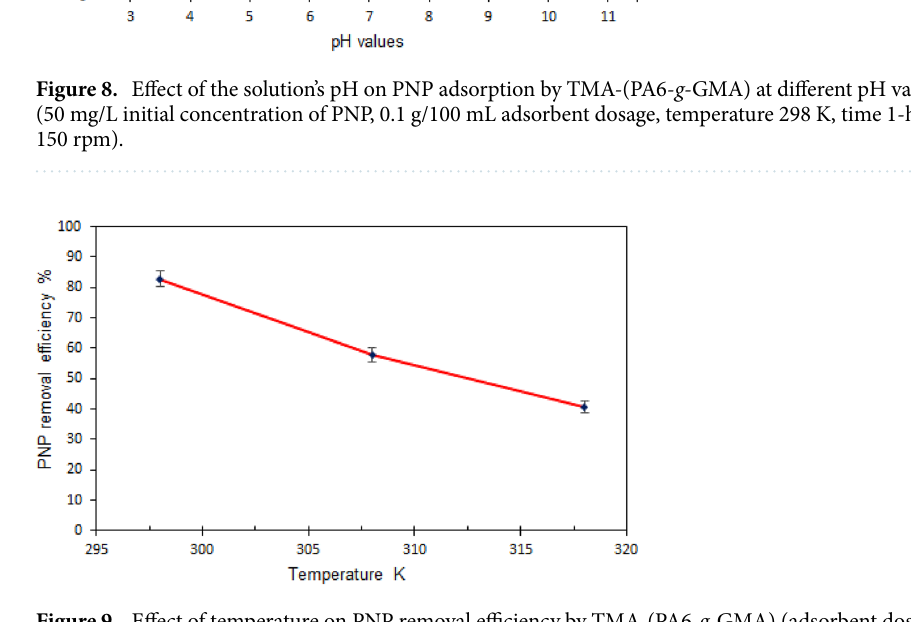
Figure 9. Effect of temperature on PNP removal efficiency by TMA-(PA6- g -GMA) (adsorbent dose: 0.1 g/100 mL; PNP initial concentration: 50 mg/L, pH 5, time: 1 h and 150